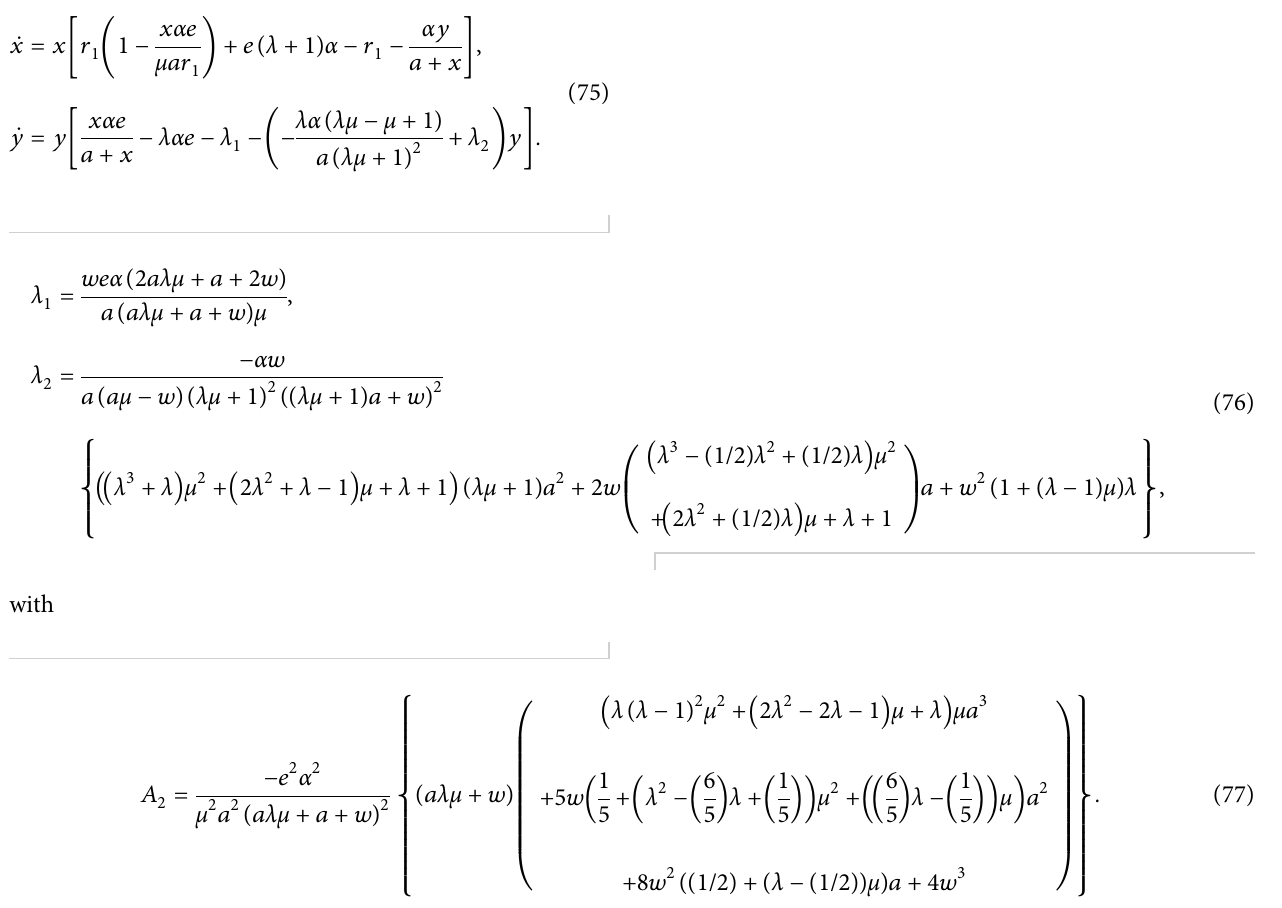
� 1; (b) Unstable node E with r 6 1